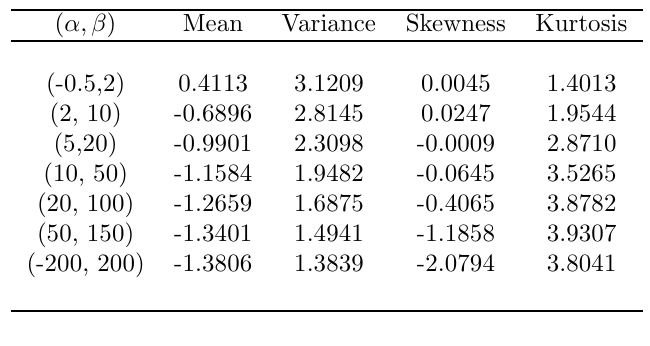
Mean, Variance, Skewness and Kurtosis of the MSLD for particular choice of α and β